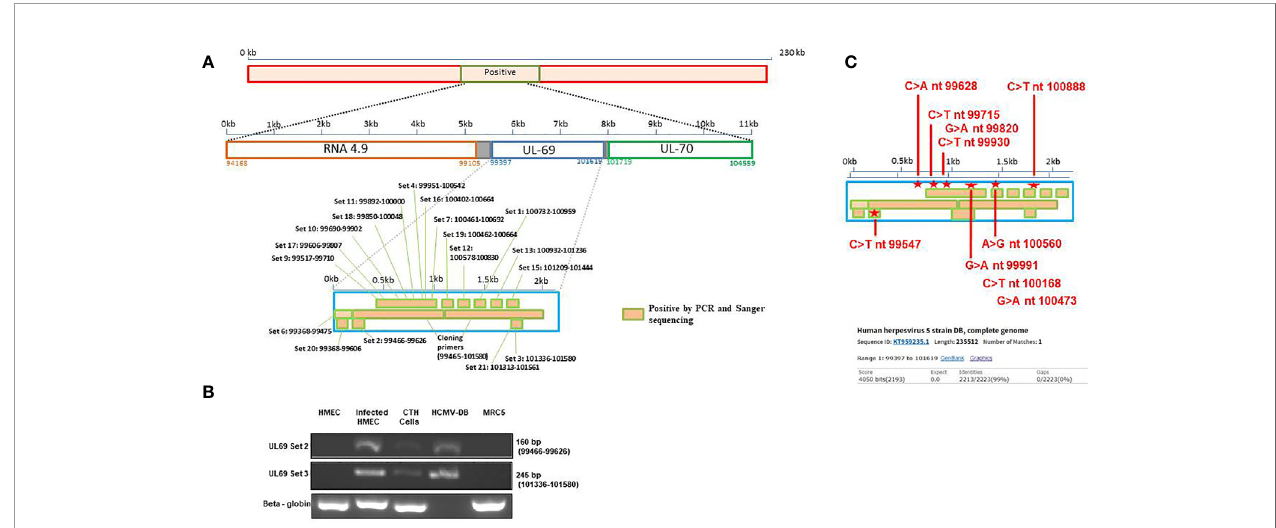
FIGURE 1 | Detection of UL69 gene in CTH cells. (A) Screening strategy used to detect HCMV UL69 sequences in CTH cells using PCR assay. (B) UL69 amplicons detection in CTH cells using conventional PCR. Uninfected HMECs and MRC5 cells were used as negative controls; HCMV-DB viral stock and infected HMECs were considered as positive controls. b -globin was used as an internal control. Agarose gels show results representative of three independent experiments. The complete primer sets used are described in Supplementary Table 1 . (C) Detection of nucleotide point mutations in HCMV-DB UL69 sequence present in CTH cells compared to wild-type HCMV-DB